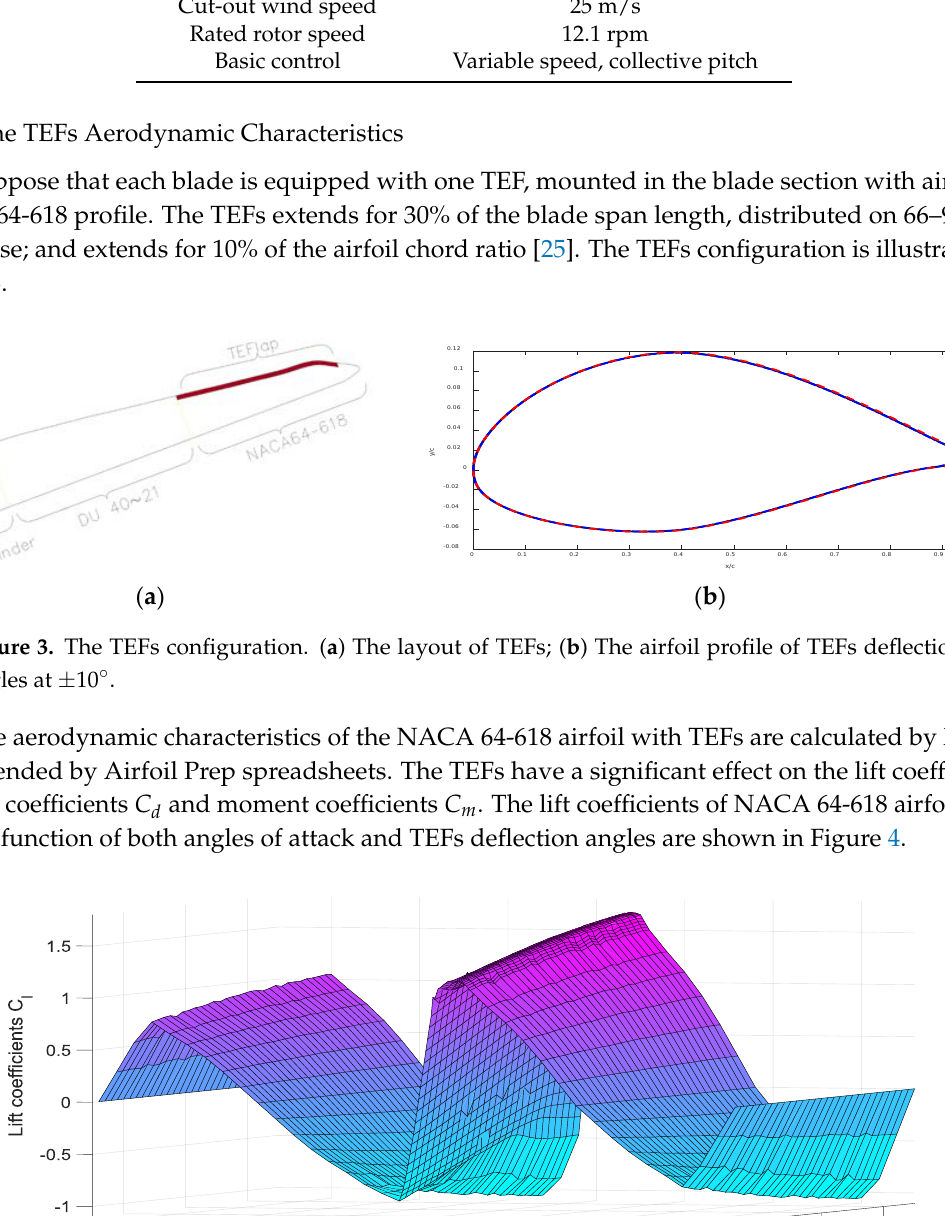
Figure 4. The lift coefficients as function of both angles of attack (±180°). and TEFs deflection angles (±15°). 4.1.3. The Anti-Windup Scheme of Blades and TEFs Considering the dynamic characteristics of blades and TEFs, the blade-pitch rate is limited to 8°/s in absolute value; and the minimum and maximum blade pitch angles are limited to [0°–90°]. The TEFs deflection rate is limited to 40°/s in absolute value; and the minimum and maximum TEFs deflection angles are limited to [−15°–+15°]. 4.2. Simulation Environment 4.2.1. Simulation Platform The simulation is carried out on the joint simulation platform of FAST code and MATLAB software. The FAST code is used to perform time marching simulation of aero-elastic response of wind turbines. The MATLAB software is used to implement the control strategy. The FAST code needs to modify and recompile for integrating TEFs interface. Then FAST code is used as S-function which is called by MATLAB software. 4.2.2. Design Loads Case The design loads cases (DLC) focus on the wind turbines fatigue loads of normal power production, according to DLC 1.2 of IEC 61400-1 [26]. The turbulent wind is assumed to belong to Class IIB, normal turbulence model (NTM) with Von Karman spectrum. The turbulence intensity ref I is 0.14 while the reference wind speed ref V is 42.5 m/s. The hub height mean wind speed is assumed to 20 m/s, and wind shear model with power law exponent is 0.2. The turbulent wind data